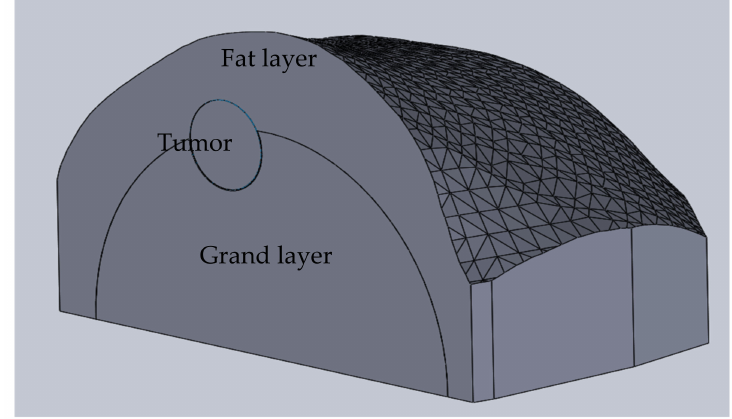
Figure 16. A 3D model with computed parameters (Patient No. 2).